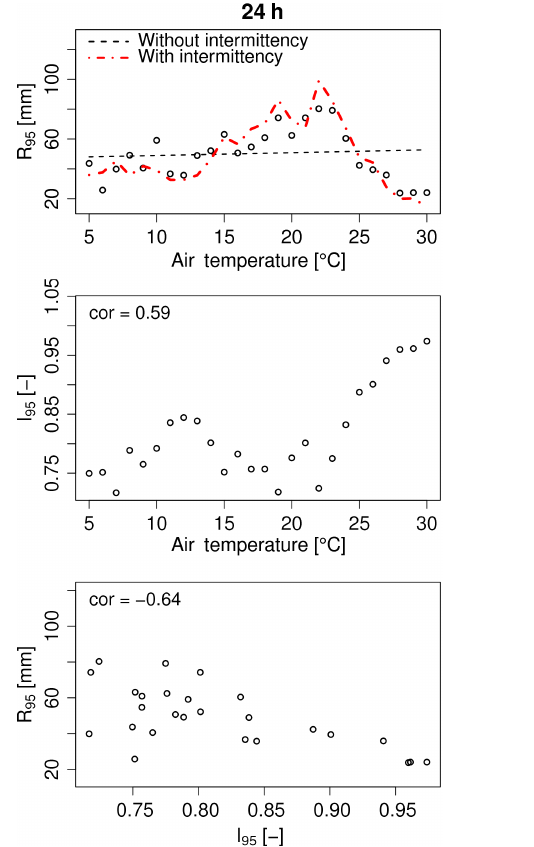
Figure 5. The 95th quantile of rainfall amounts at the daily timescale as a function of temperature and intermittency at AL- Fairhope-3-NE. Black dots denote sample estimates. The black and red lines represent the fitted scaling models given in Eqs. (9) and